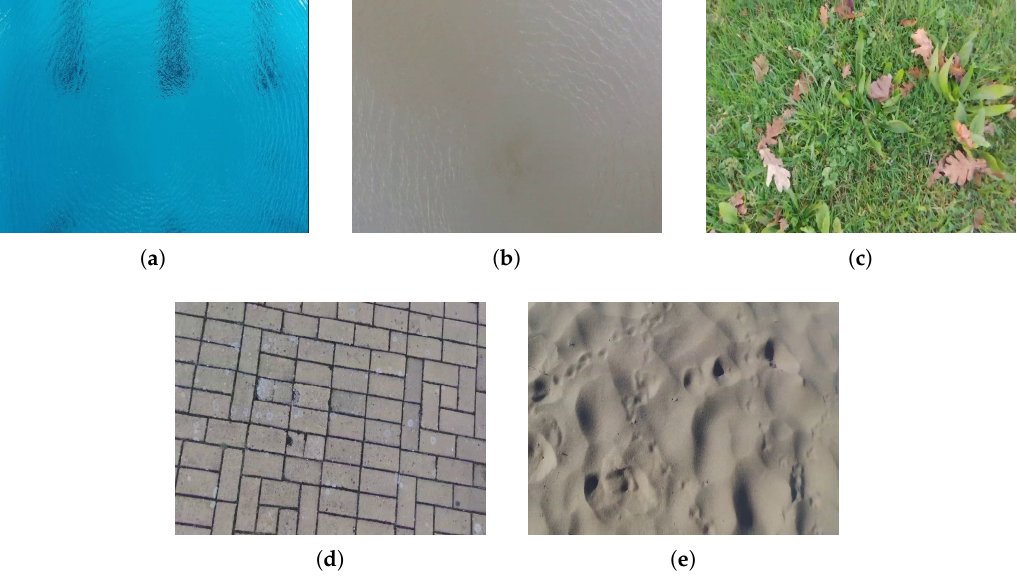
Figure 3. Examples of terrain types: water ( a , b ); vegetation ( c ); asphalt ( d ) and sand ( e ).